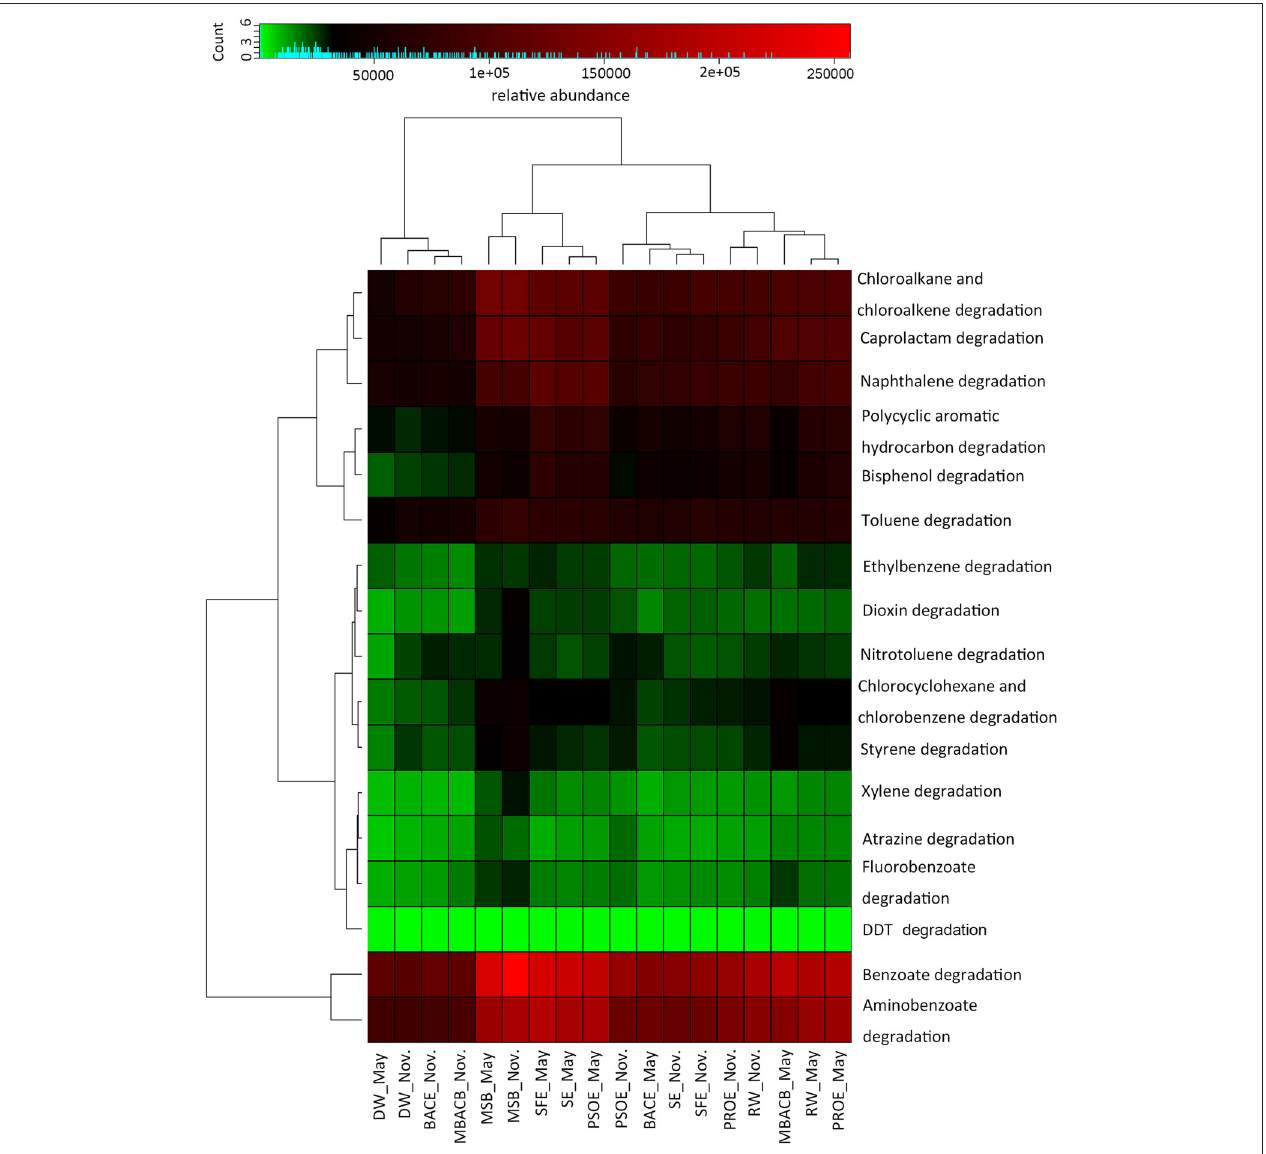
FIGURE 8 | Heatmap of functional genes relating to pollutant degradation predicted using PICRUSt along the treatment processes in November and May. The relative abundance of each functional gene is indicated by color intensity with the legend at the top. The upper and left panels show the hierarchical clustering. The abbreviations of the samples are the same as used in Table 2 . DDT is short for